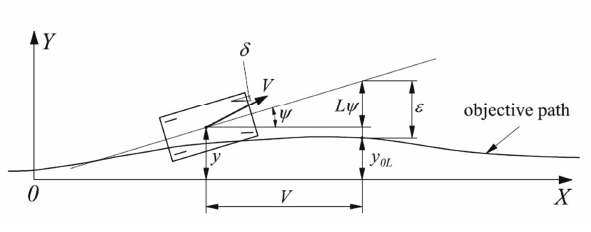
Fig. 2. The motion of the vehicle using of the anticipatory driver model